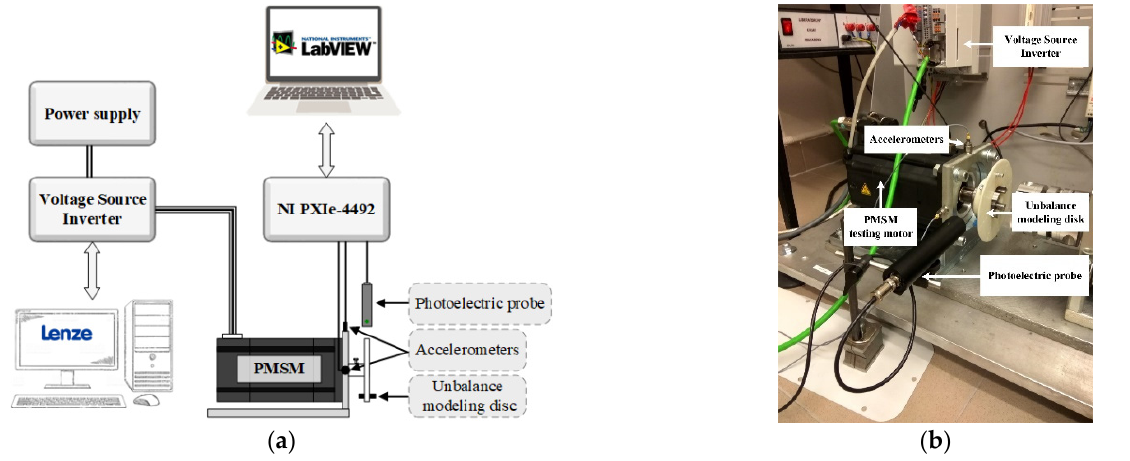
Figure 5. Scheme of PMSM rotor unbalance tests ( a ) photo of the experimental setup ( b ).